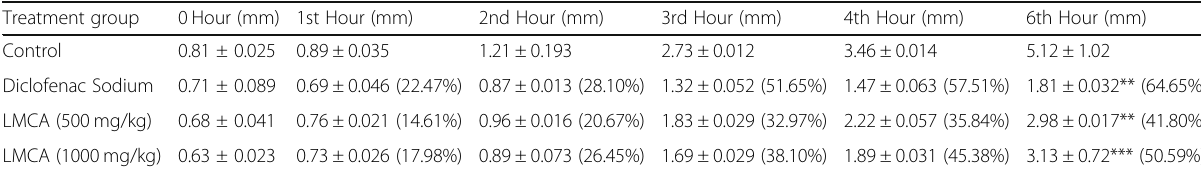
Table 7 Anti-inflammatory activity of LMCA by carrageenan induced paw edema method Treatment group